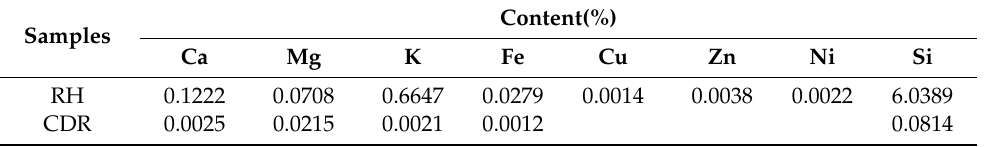
Table 2. XRF analysis results of cresol distillation residue and rice